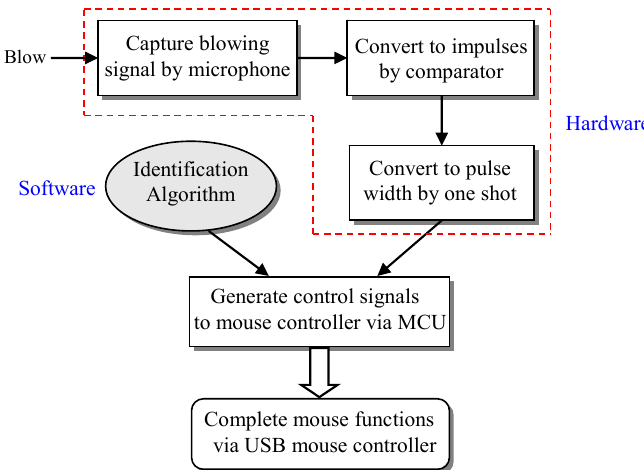
Figure 10. The implementation procedure of the proposed blowing-controlled mouse.